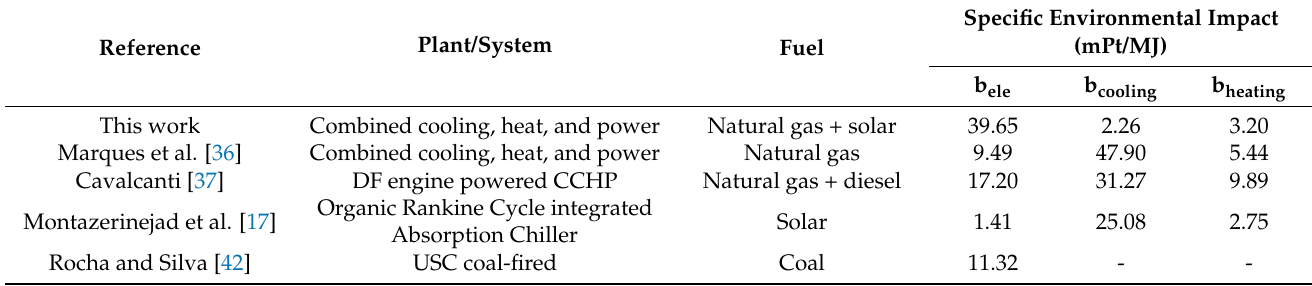
Table 8. Specific environmental impact for products of generation